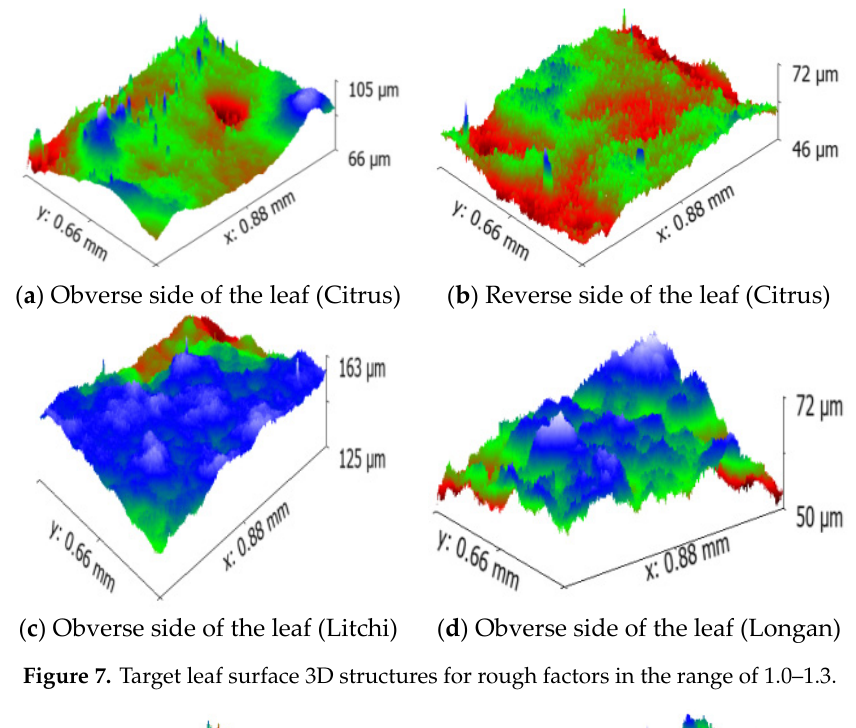
Figure 7. Target leaf surface 3D structures for rough factors in the range of 1.0–1.3.